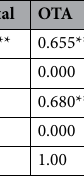
Table 14. Associations of mycotoxins (AFB 1 , AFtotal and OTA) in maize from Western Region. **Correlation is significant at the 0.01 level